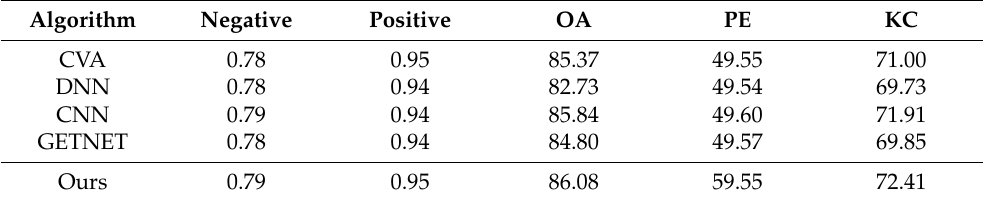
Table 3. Quantitative evaluation of experimental results of different methods on Bay Area data